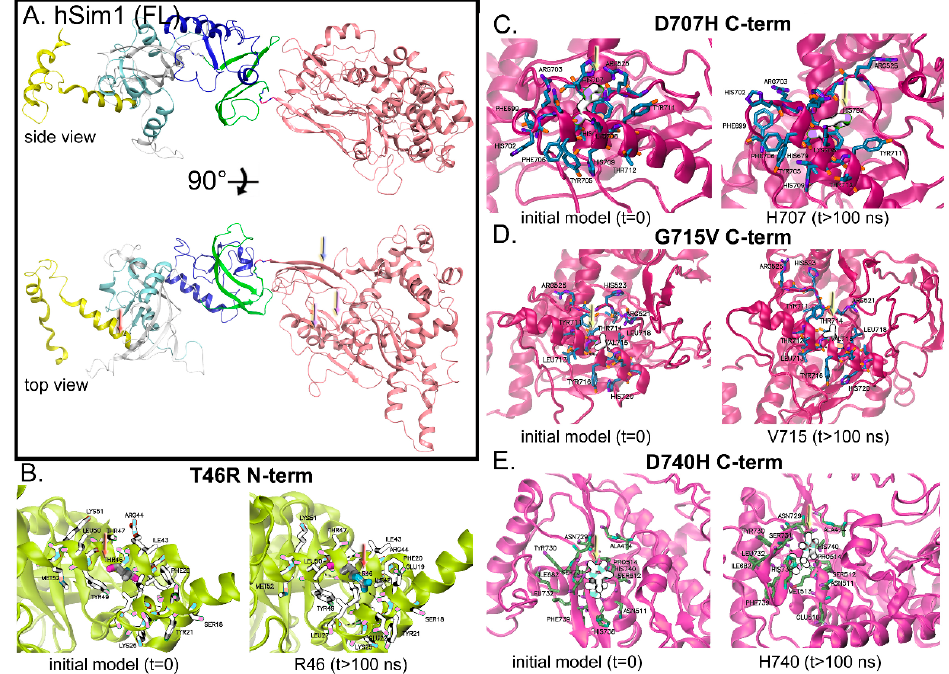
Figure 4. Molecular dynamics simulations demonstrate reorganization of the pathogenic site on SIM1. ( A ) The monomeric, unbound form of SIM1 shown with the same two orientations from Figure 1. Rendered in ribbons and colored by domain. ( B ) T46R mutant at zero time and after 100 ns. ( C ) D707H mutant at zero time and after 100 ns. ( D ) G715V mutant at zero time and after 100 ns. ( E ) D740H mutant at zero time and after 100 ns. Ribbons colored by domain and residues within 8 Å of the mutant are shown in licorice stick rendering. The mutant residue is shown in exaggerated Goodsell rendering.